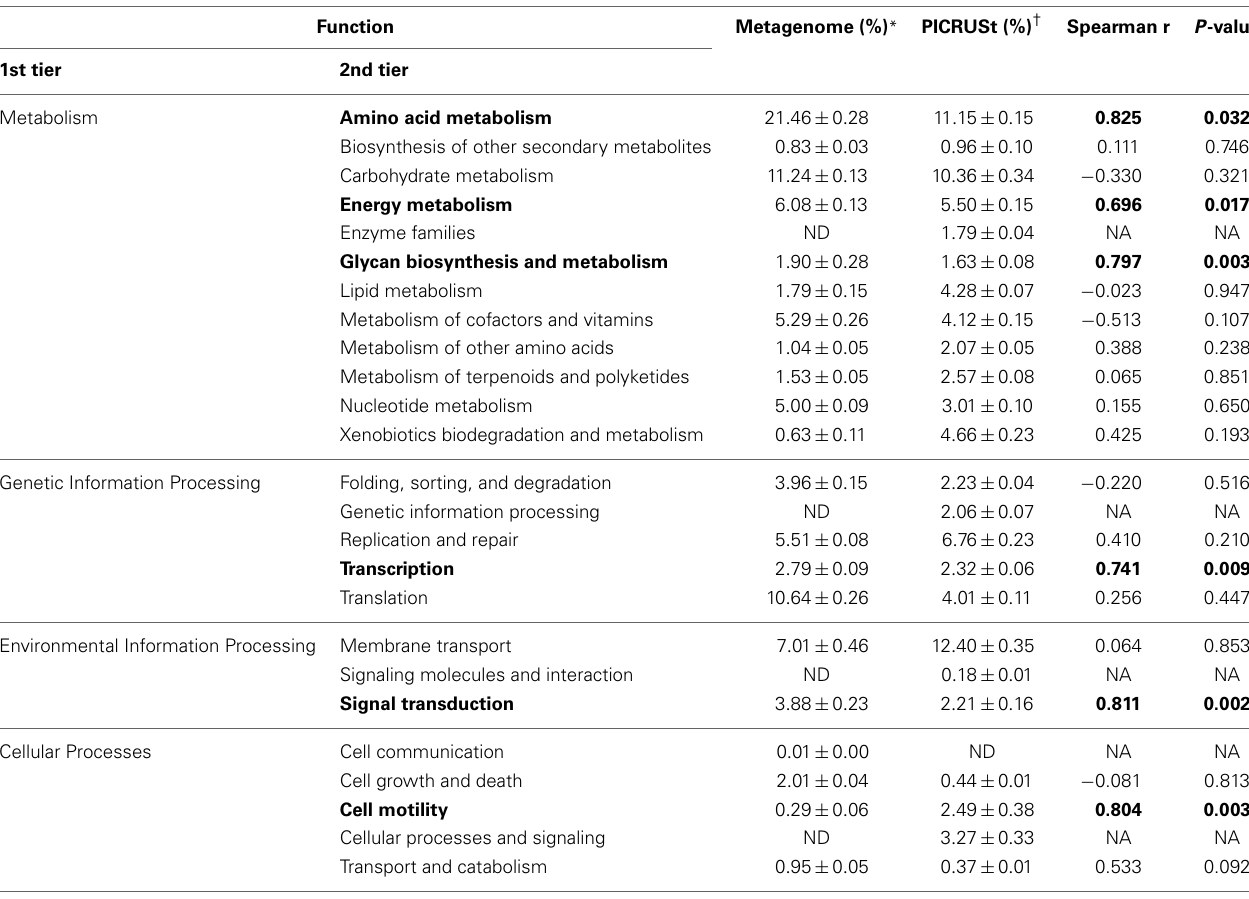
Table 2 | Correlations of predicted second-tier functional abundances between metagenomic and PICRUSt